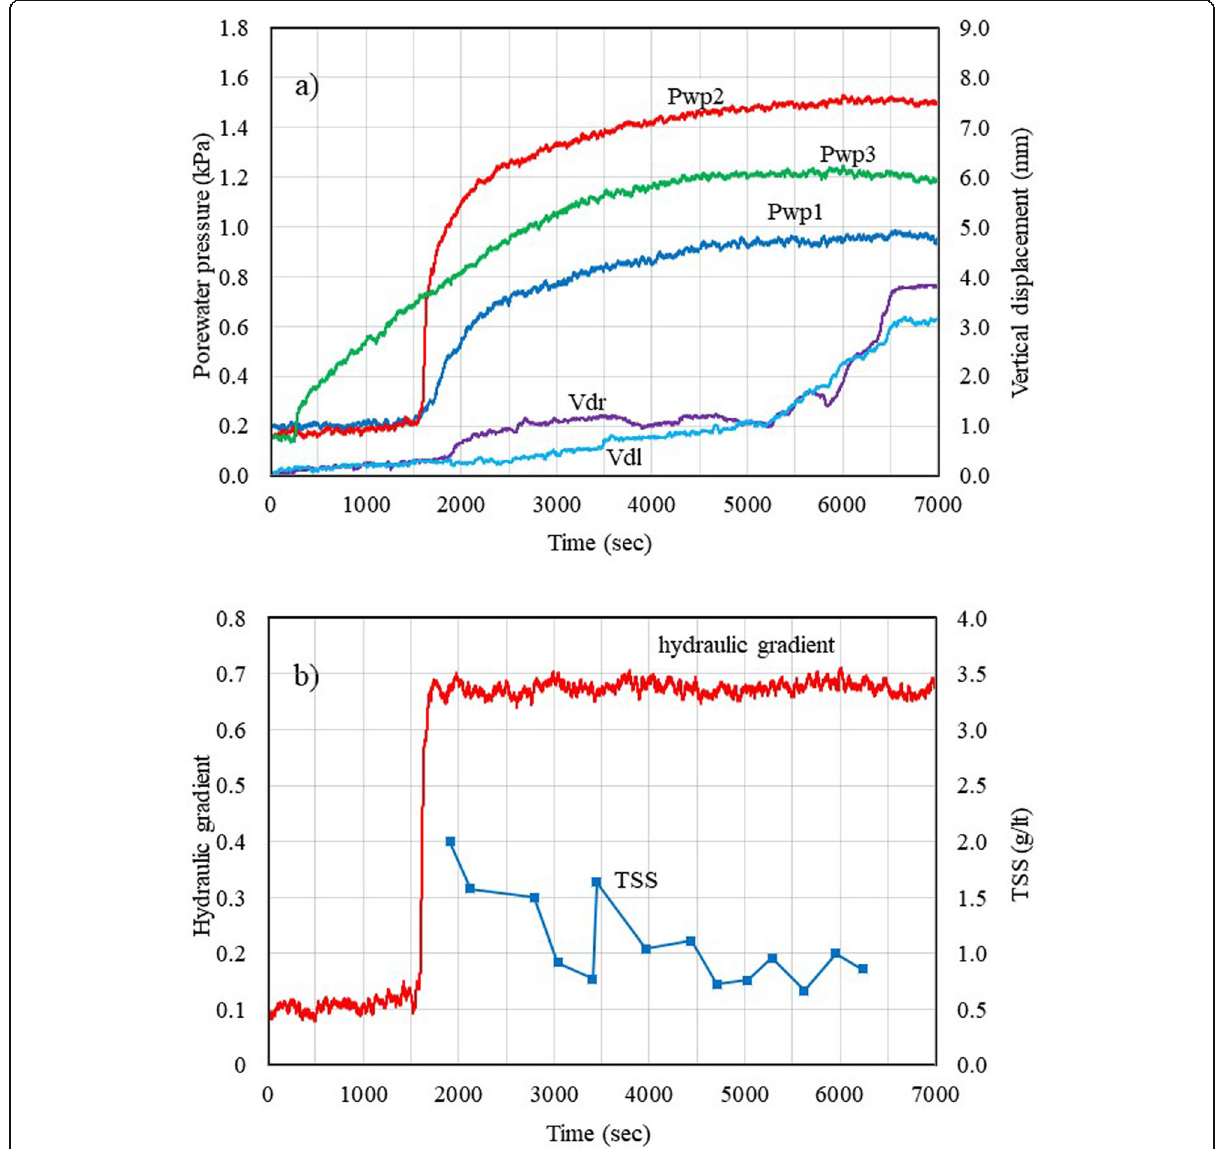
Fig. 9 Experiment results of experiment No. EXP 3NF of GIII sample. a Pore water pressure and vertical displacement b Hydraulic gradient and